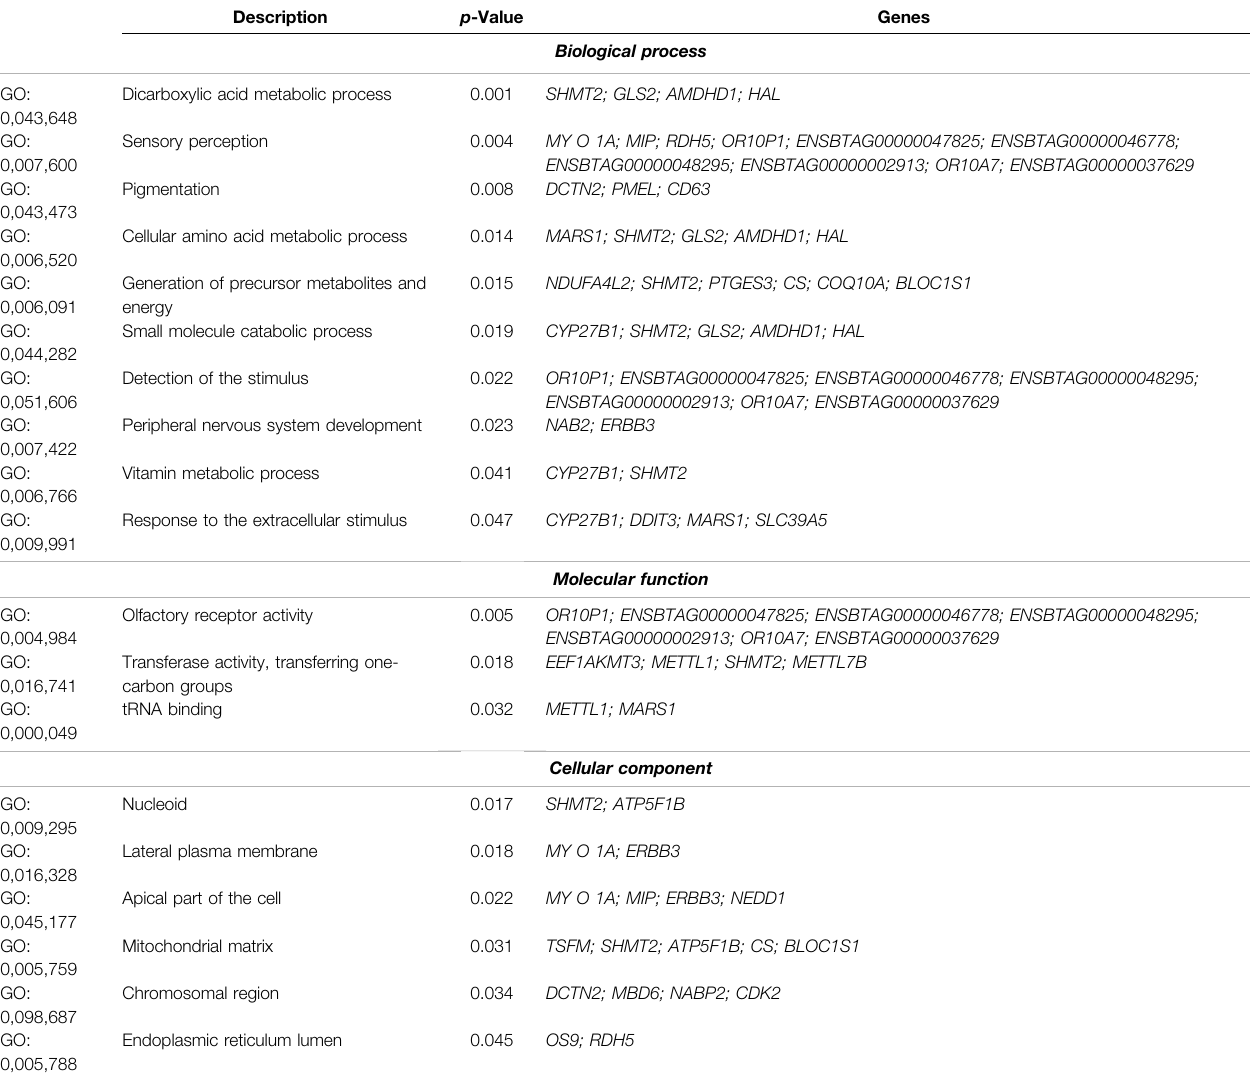
TABLE 3 | Signi fi cant ( p < 0.05) Gene Ontology (GO) terms for the genes located within runs of homozygosity regions in the Purunã breed. Description p -Value Genes Biological